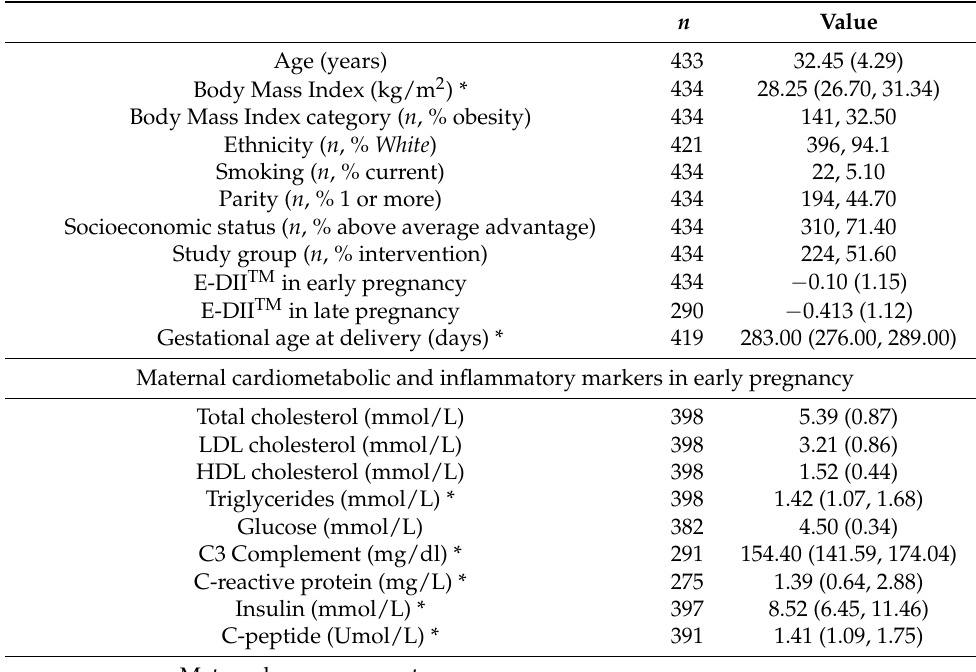
Table 1. Maternal and foetal